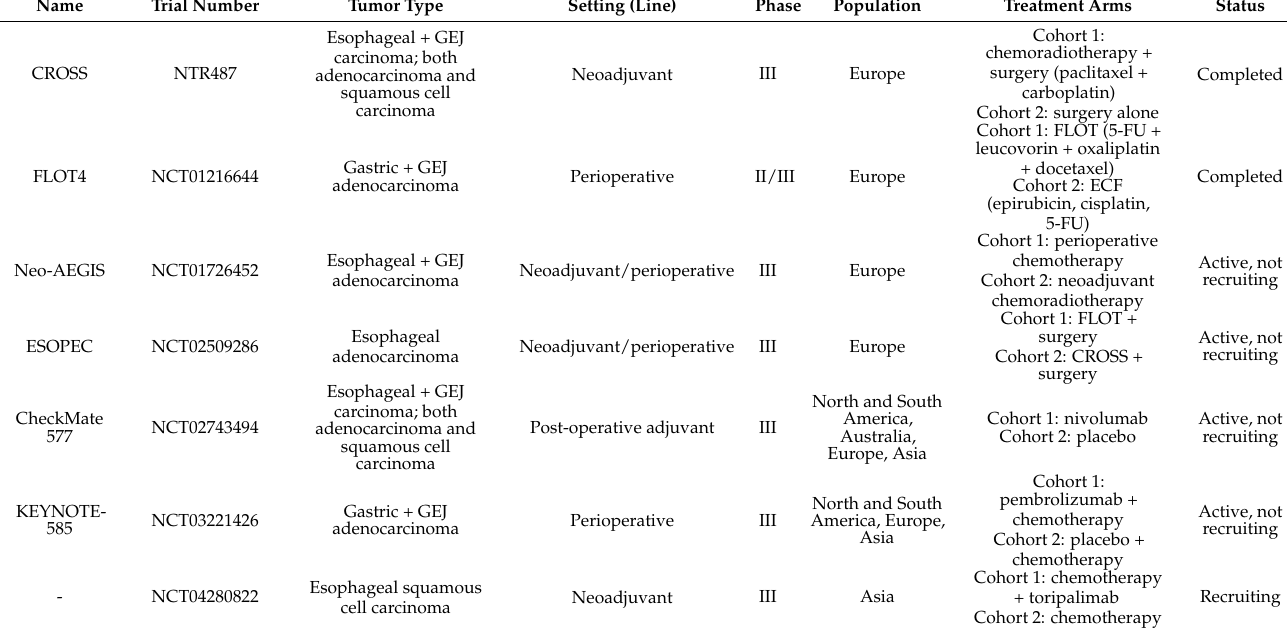
Table 1. Overview of recent clinical trials discussed in this review in patients with resectable esophageal